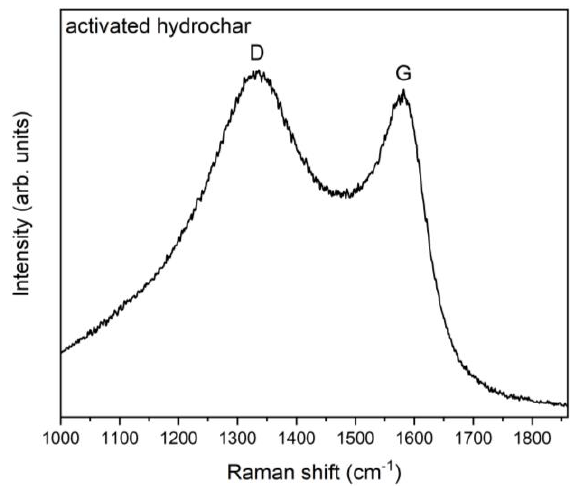
Figure 7. Raman spectrum of activated microspheres, with I D / I G = 1.17. 175